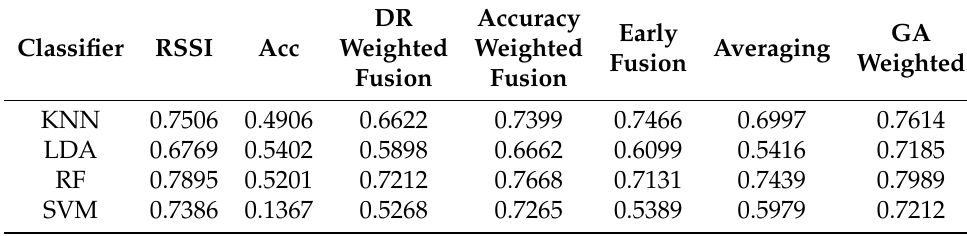
Table 2. Accuracy values for the living room gateway.